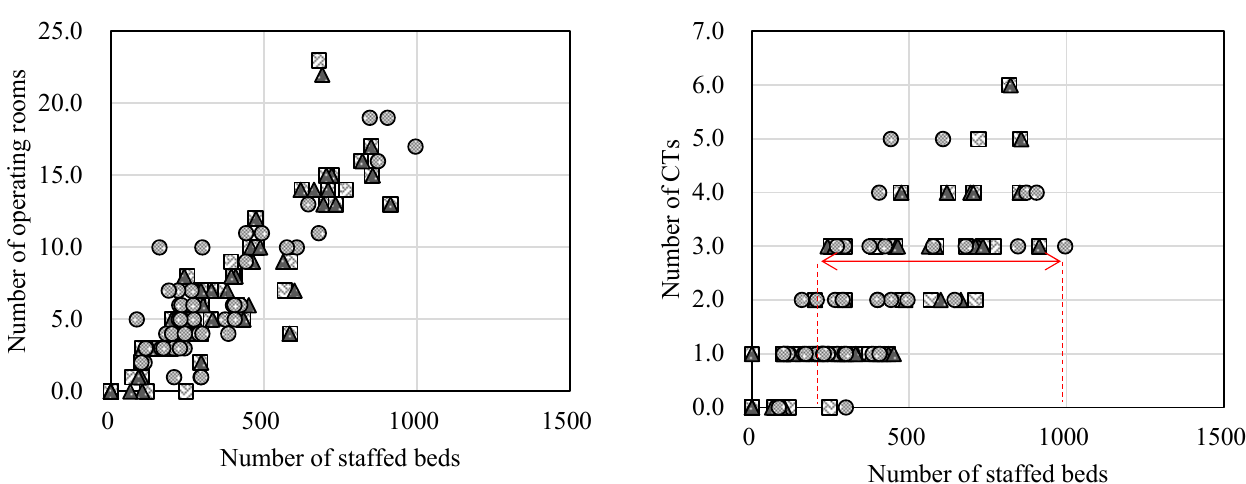
Figure 4. Trend and variance of the number of CT and operating rooms according to the number of staffed beds.